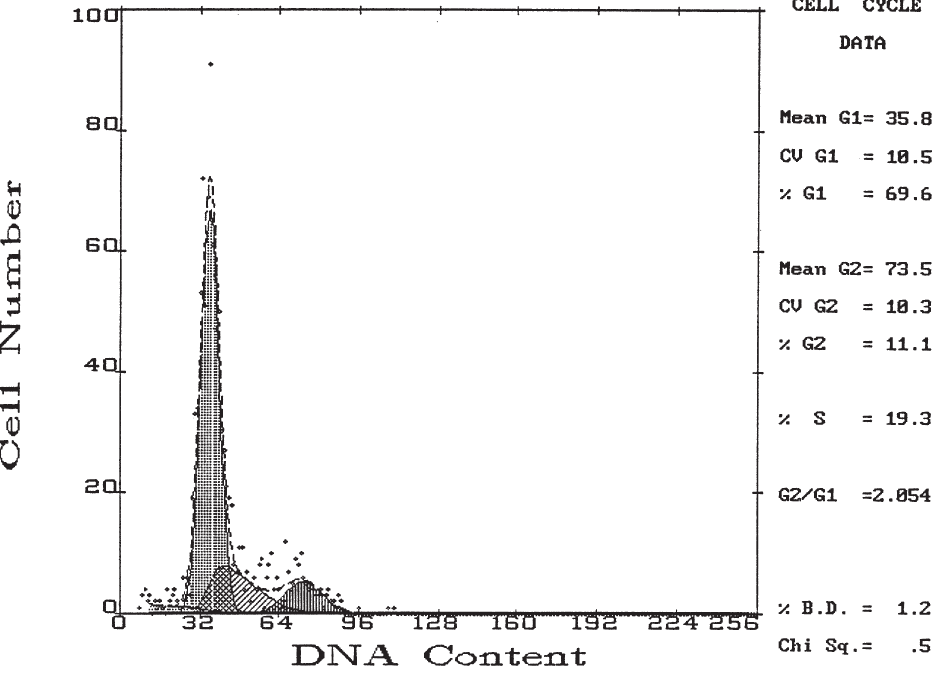
Fig. 1. Typical cell cycle analysis histogram obtained using the M-Cycle software after data acquisition of the flow cytometer. model [6] with the specific software MultiCycle AV (Phoenix Flow Systems, San Diego, CA,